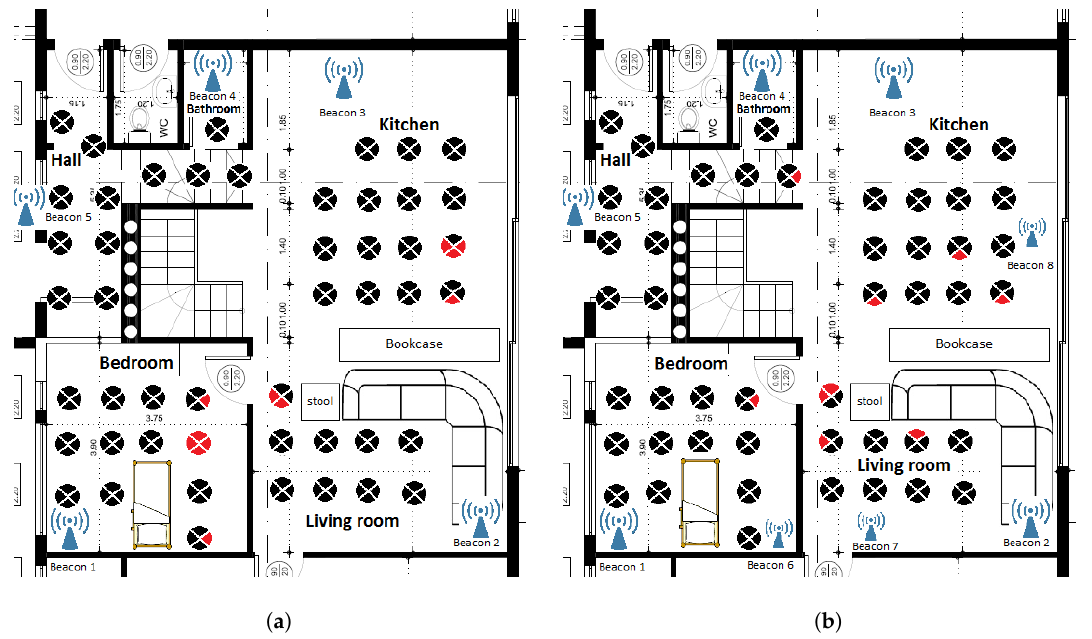
Figure 7. The results from the 2 conducted tests. ( a ) The floorplan of the house where the evaluation test was conducted. Each section of the circle represents a different direction of the user. Red color represents wrong room estimations; ( b ) The results of the second experiment where the number of beacons increased from five to eight. Each section of the circle represents a different direction of the user. Red color represents wrong room estimations.